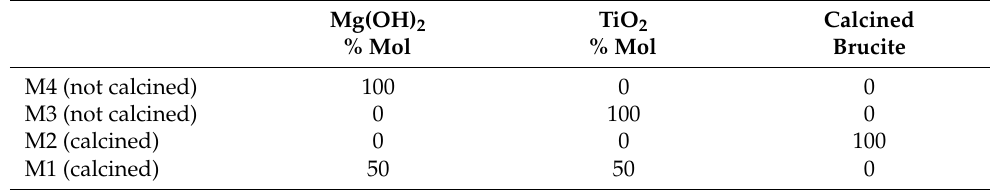
Table 3. List of formulations